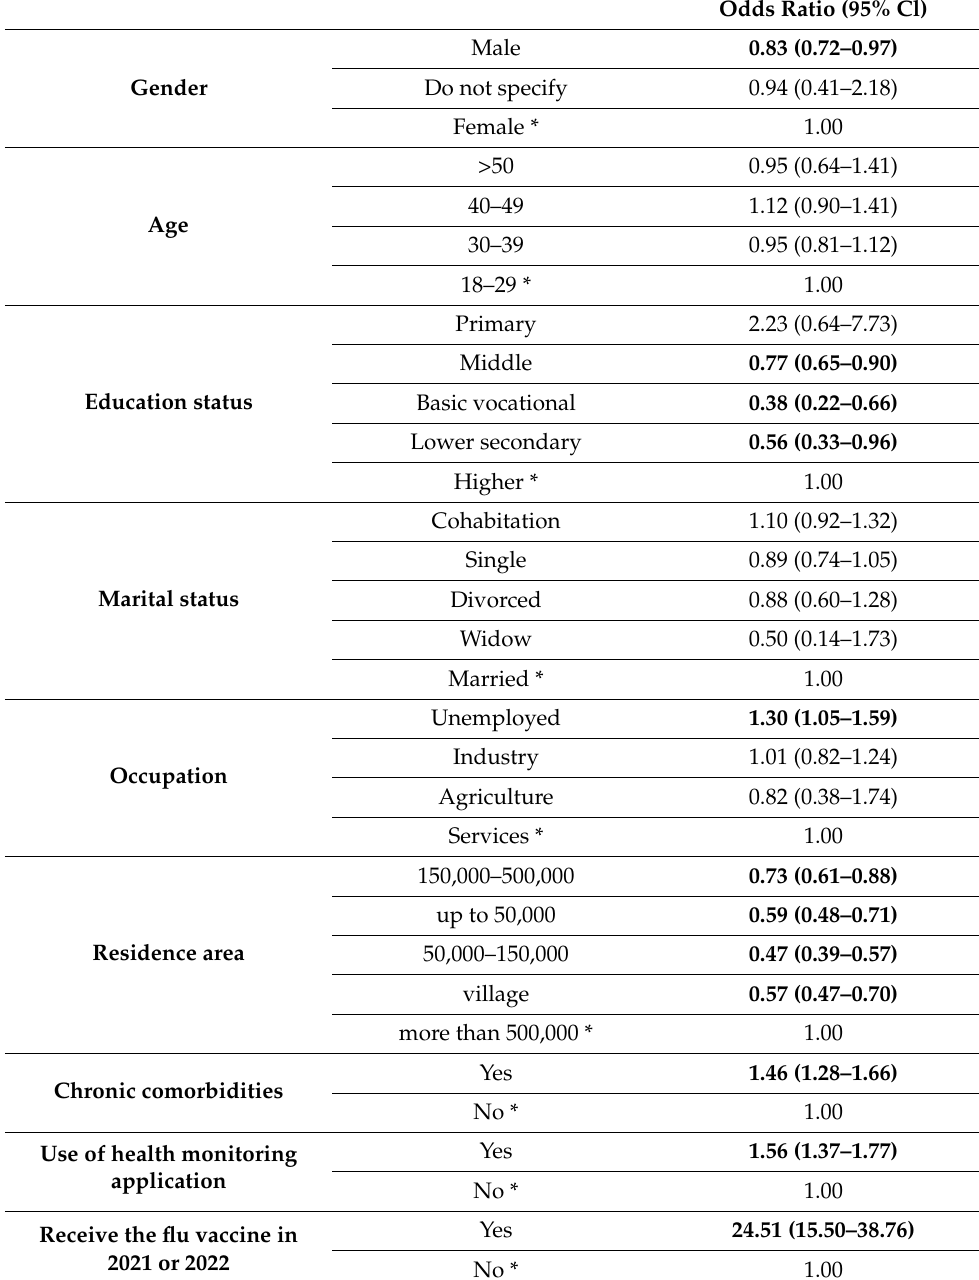
Table 3. Multivariable logistic regression analysis of factors associated with COVID-19